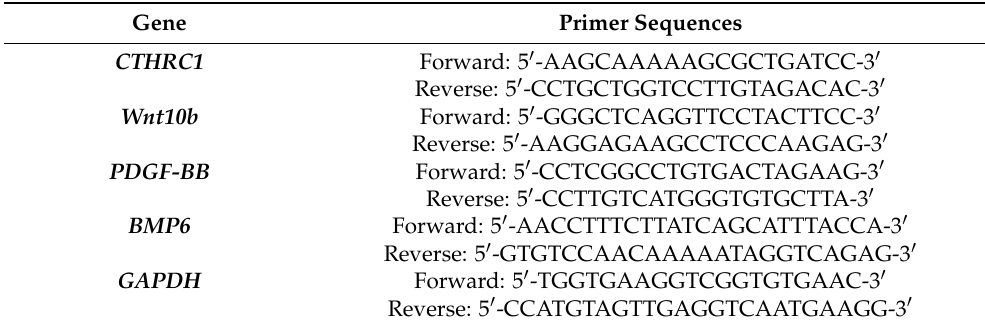
Table 4. PCR primer pairs (BMM-derived cells).